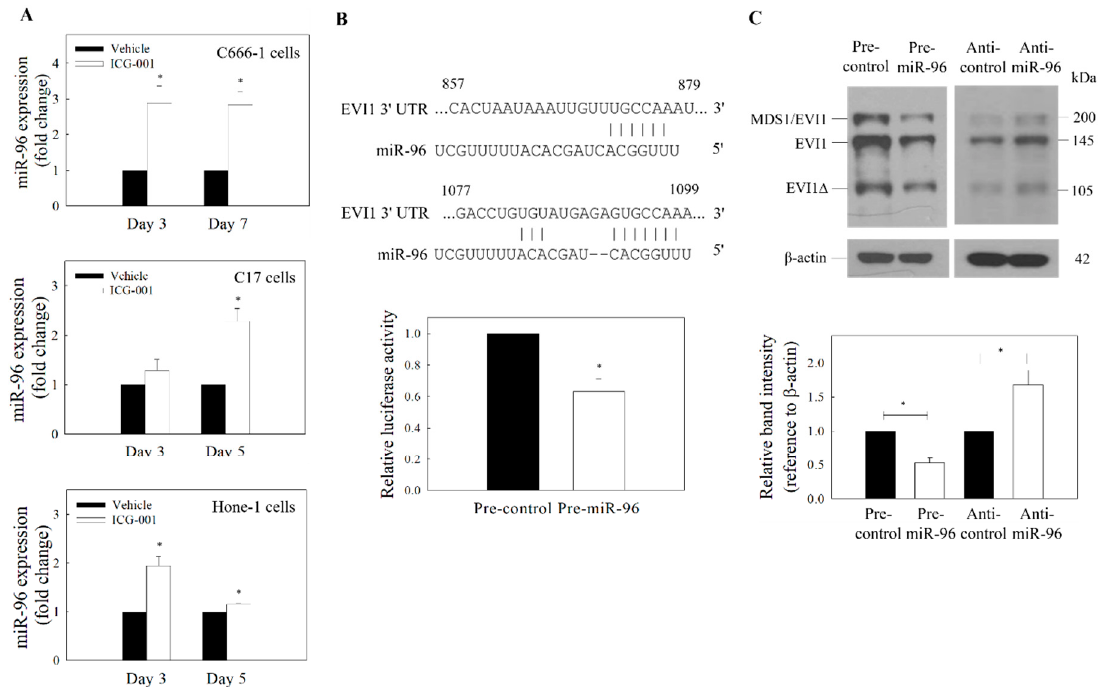
Figure 3. Expression of miR-96 and EVI1. ( A ) qRT-PCR analysis of ICG-001-induced expression of miR-96. ICG-001 upregulates the expression of miR-96 in the EBV-positive (C666-1 and C17) and EBV-negative (Hone-1) cells. ( B ) Putative binding site of miR-96 on EVI1 mRNA 3 ′ -UTR was predicted using TargetScan (upper panel). The EVI1 3 ′ UTR luciferase reporter assay (lower panel) was performed in C666-1 cells. ( C ) Effect of miR-96 on the expression of EVI1. C666-1 cells were transfected with pre-miR-96 or anti-miR-96. Upper panel: Protein blot. Lower panel: Quantitative analysis of EVI1 expression from the protein blot. Values are presented as the mean ± SD of at least three independent experiments. * p < 0.05 compared with the corresponding control.